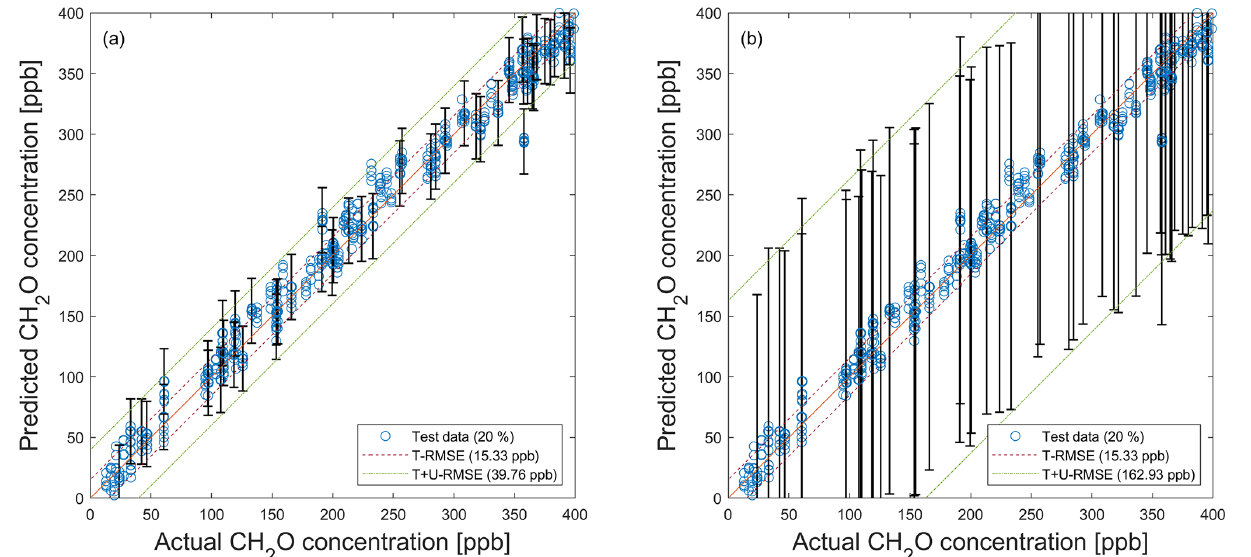
Figure A1. PLSR model (trained with raw data; n comp = 20) applied to test data (see Fig. 5) for the quantification of formaldehyde and the propagated uncertainty. (a) SNR = 55dB. (b) SNR = 40dB. Dashed red and green lines indicate the test RMSE (T − RMSE) and the test plus uncertainty RMSE (T + U − RMSE) based on test data, respectively. For better visibility, error bars are only shown for every 10th prediction.